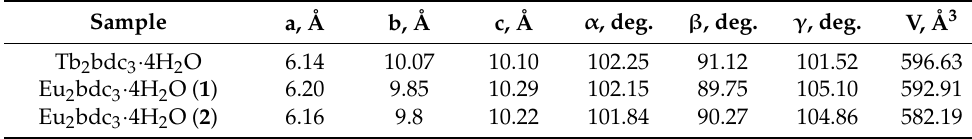
Table 2. Unit cell parameters for Tb 2 bdc 3 · 4H 2 O [32] and Eu 2 bdc 3 · 4H 2 O (Samples 1 and 2 ). Sample a,